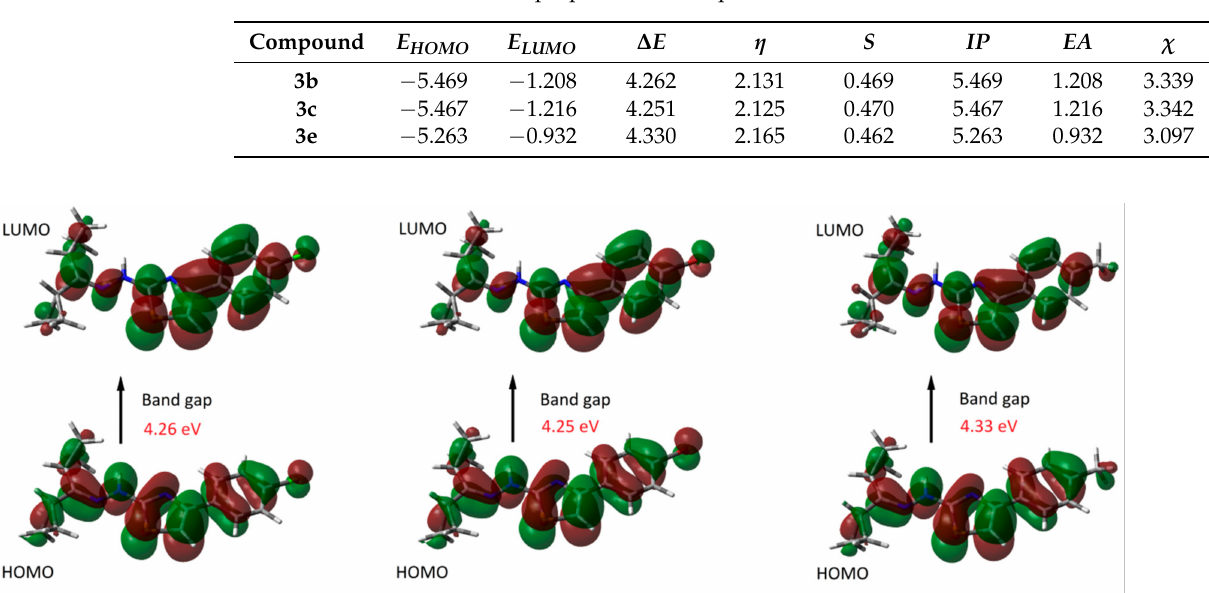
Table 10. Predicted molecular properties for compounds 3b , 3c and 3e . All results in eV.